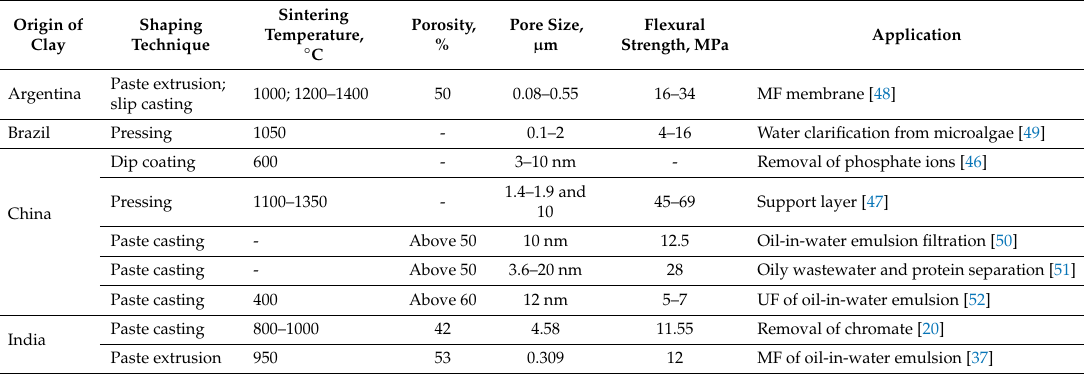
Table 2. Low-cost membranes prepared using natural